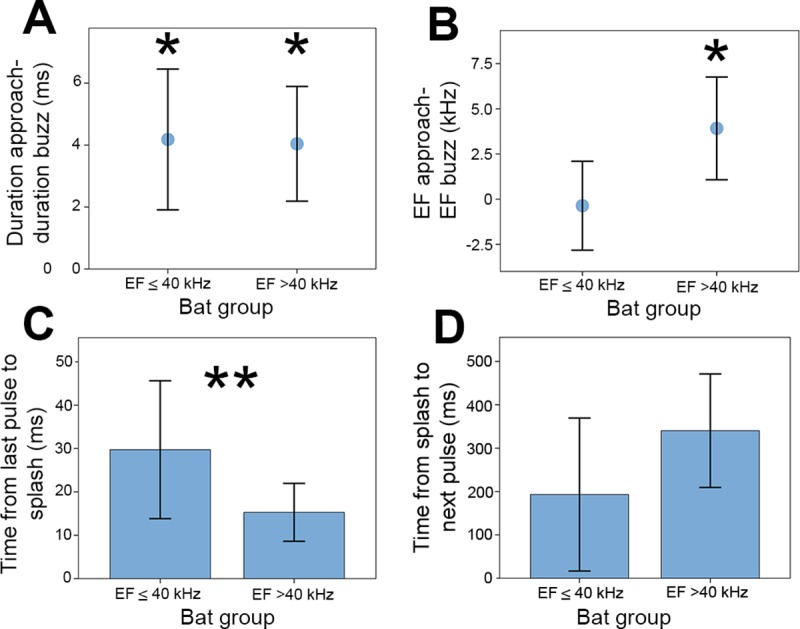
Differences in acoustic parameters between bat groups.Low frequency and high frequency bats are separated into two groups by EF (x axis on all graphs). (A) Difference in duration (ms) between approach and drinking buzz pulses calculated as: Approach pulse duration minus buzz pulse duration. (B) Difference in EF (ending frequency, kHz) between approach pulses and buzz pulses calculated as: Approach EF minus buzz EF. (C) Time (ms) from the last pulse in a drinking buzz sequence until water contact, marked with a splash in the acoustic file. (D) Time (ms) from the splash until the next pulse was produced by the bat. Data are plotted as means and one standard deviation. Terminal pulses (Fig 2) are not included in these analyses. Statistically significant values for one-sample two-tailed t-test (testing difference from 0 or no change within each bat group) for the point and error bar graphs (A, B) are indicated with an asterisk above each significant point. Statistically significant values for independent t-test comparisons comparing between bat groups (C, D) are indicated by double asterisks (**).